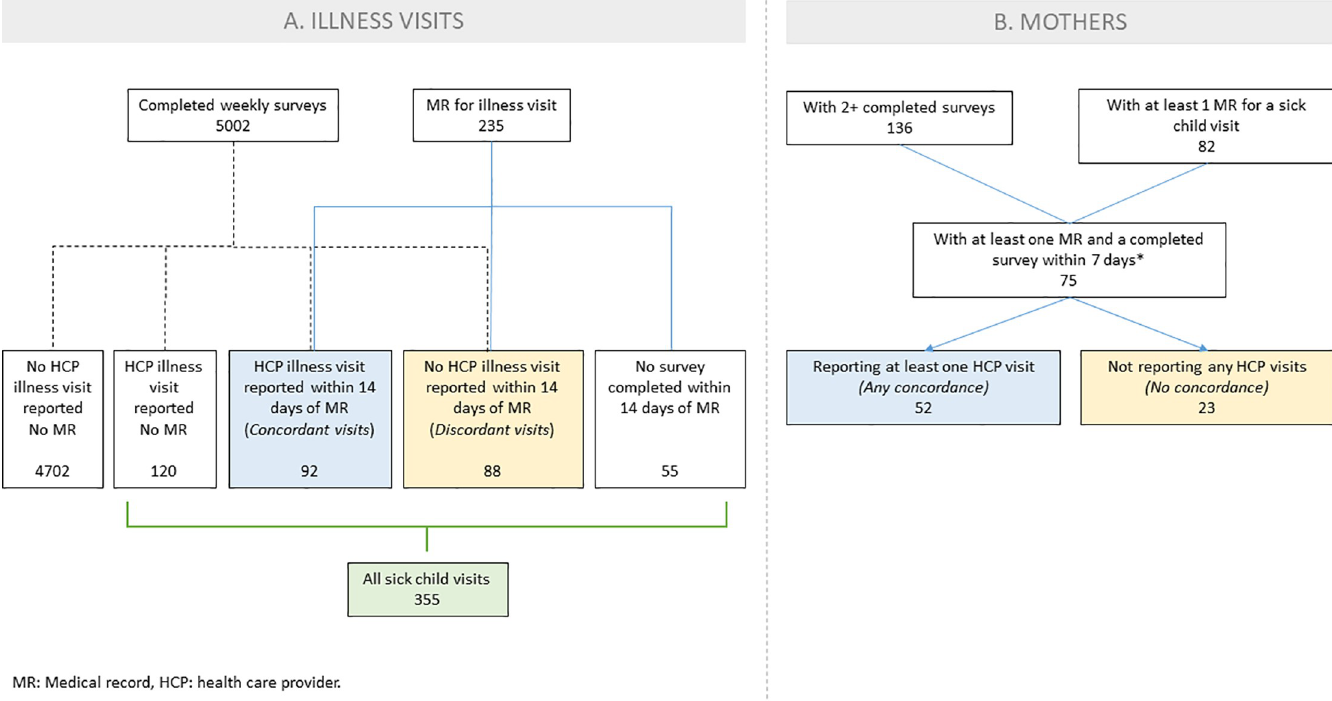
Fig 1. Visit and participant disposition. The analysis set included only visits for illness diagnosed by a HCP and documented in medical records (well-baby check-ups or scheduled visits were not considered); these 235 visits corresponded to a total of 75 babies. Blue boxes indicate: in A, the number of illness visits reported on the available surveys [concordant visits]; in B, the number of mothers reporting at least one illness visit [concordant mothers]. Yellow boxes indicate: in A, the number of illness visits not reported on the available surveys [discordant visits]; in B, the number of mothers who did not report any HCP illness visits [discordant mothers]. The green box indicates the total number of visits for illness either reported (concordant, discordant or neither) or documented (concordant, discordant or neither). HCP: health care provider; MR: medical record.